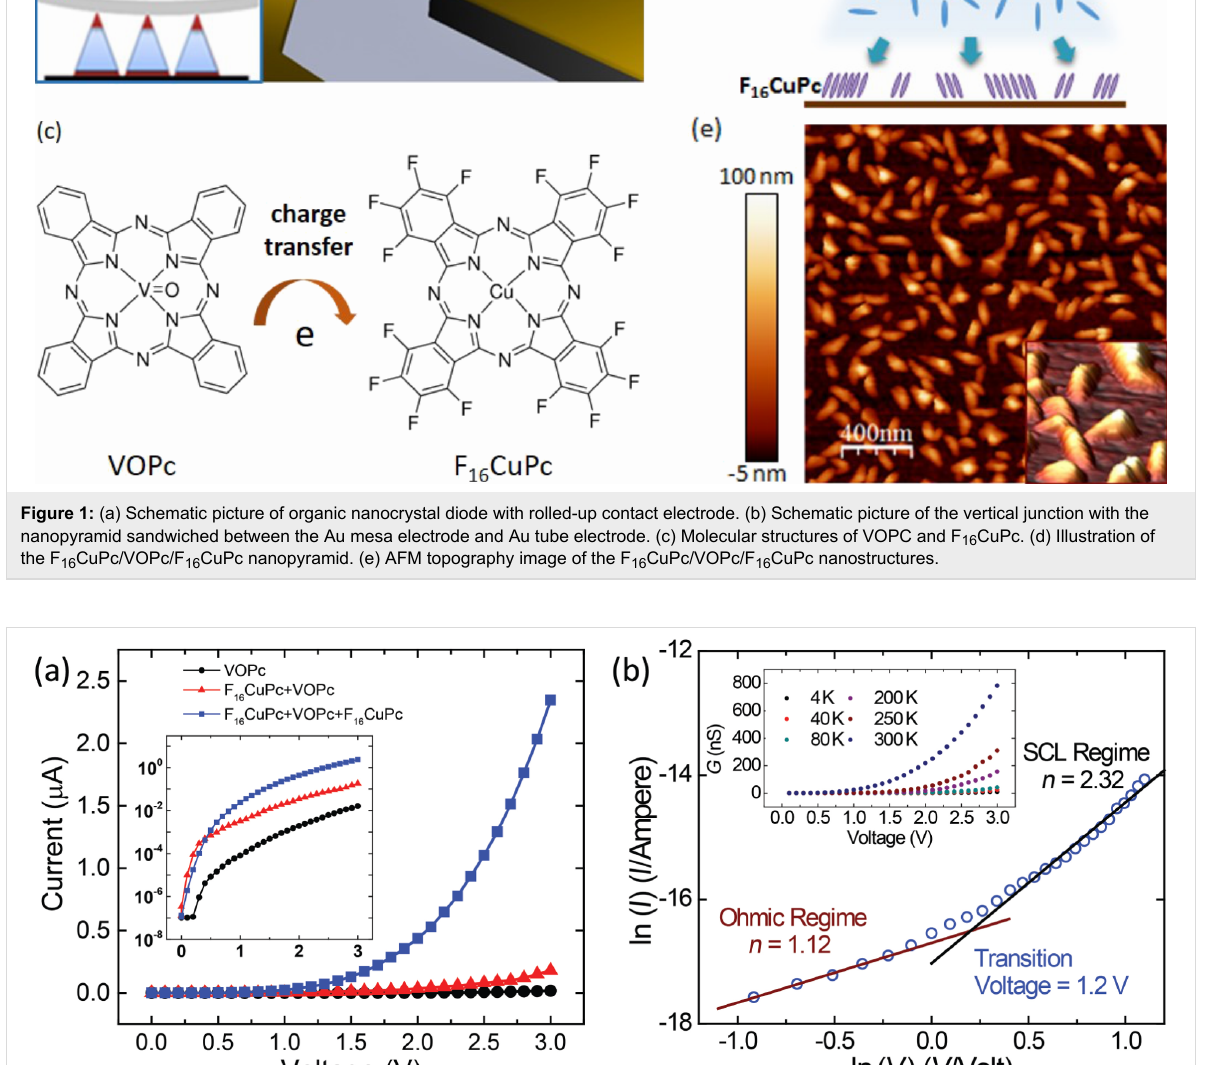
report, we will focus on the investigation of charge transport in the F 16 CuPc/VOPc/F 16 CuPc organic nanopyramid diode by applying a forward bias to the tube